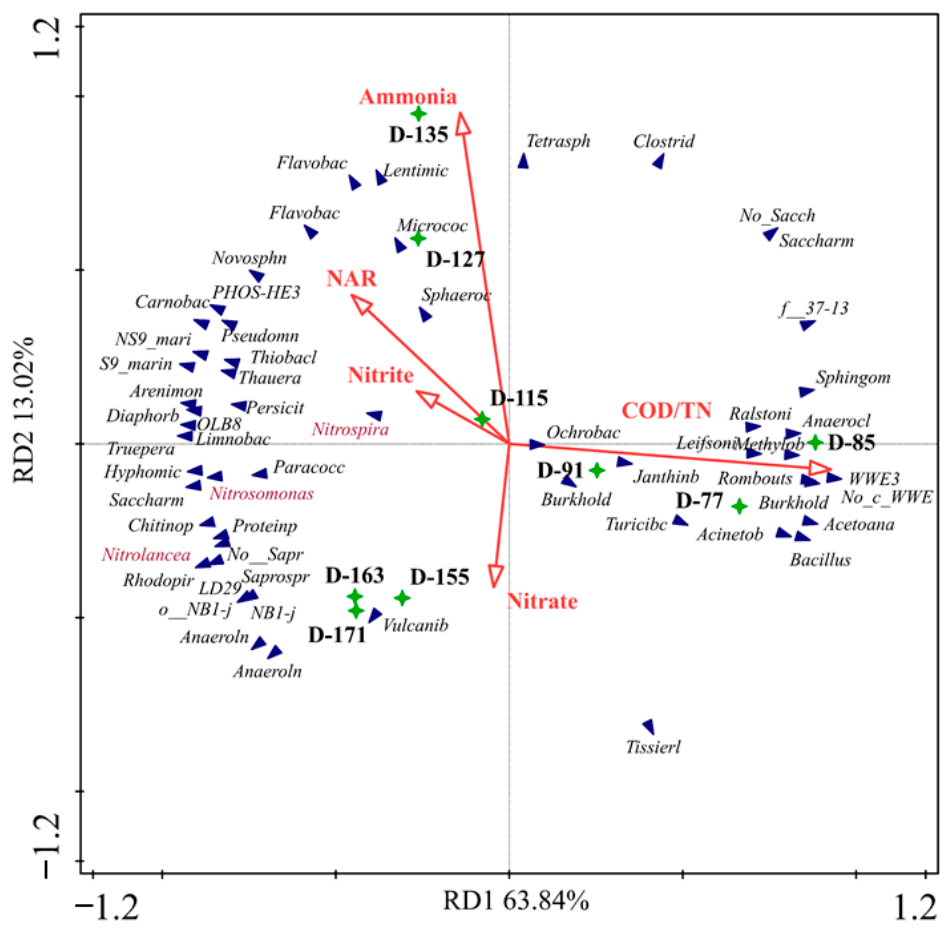
Figure 6. The redundancy analysis (RDA) of the parameters.